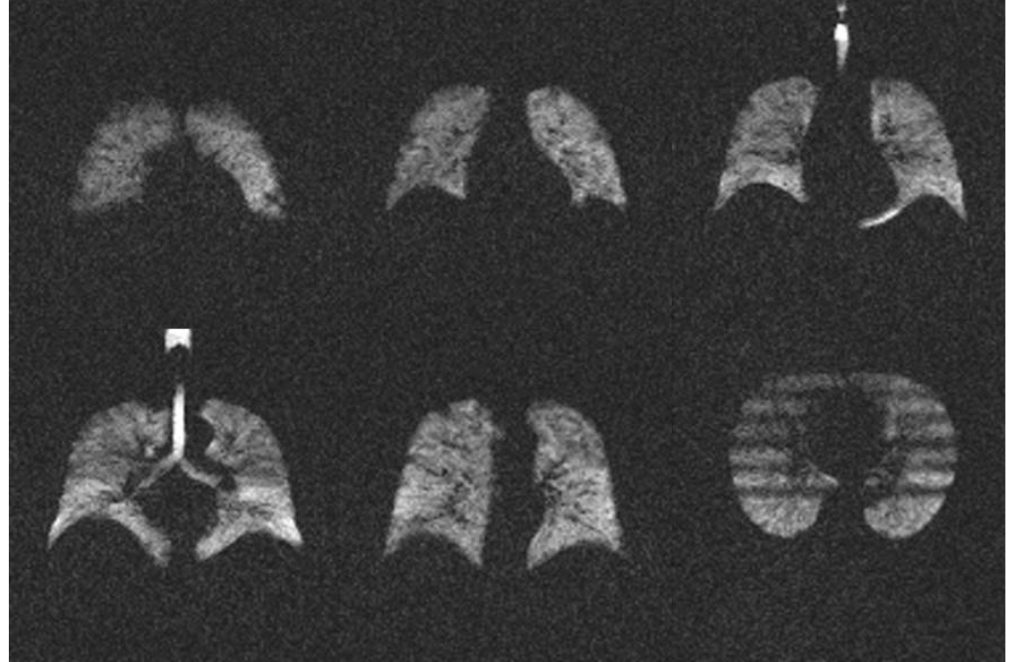
Figure 5. MR lung images of a healthy volunteer. Five coronal slices and one transversal slice are shown.